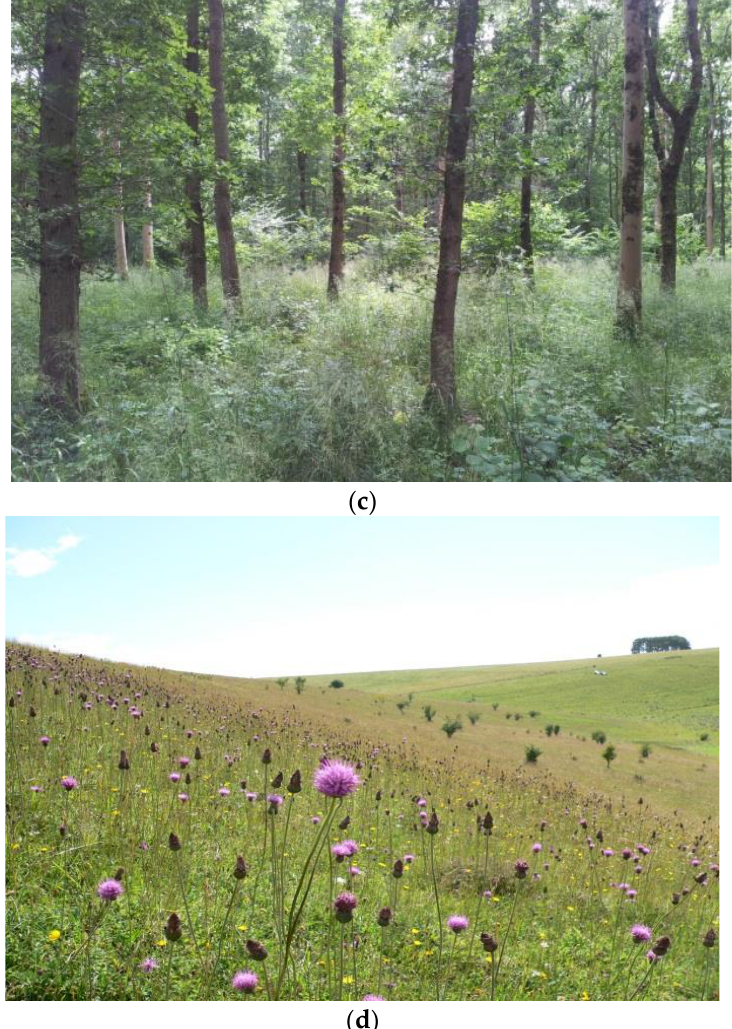
Figure 1. Photographs showing habitats in the Salisbury Plain area of Wiltshire including: ( a ) cropland; ( b ) rivers and wetlands; ( c ) woodlands; and ( d ) chalk grasslands.